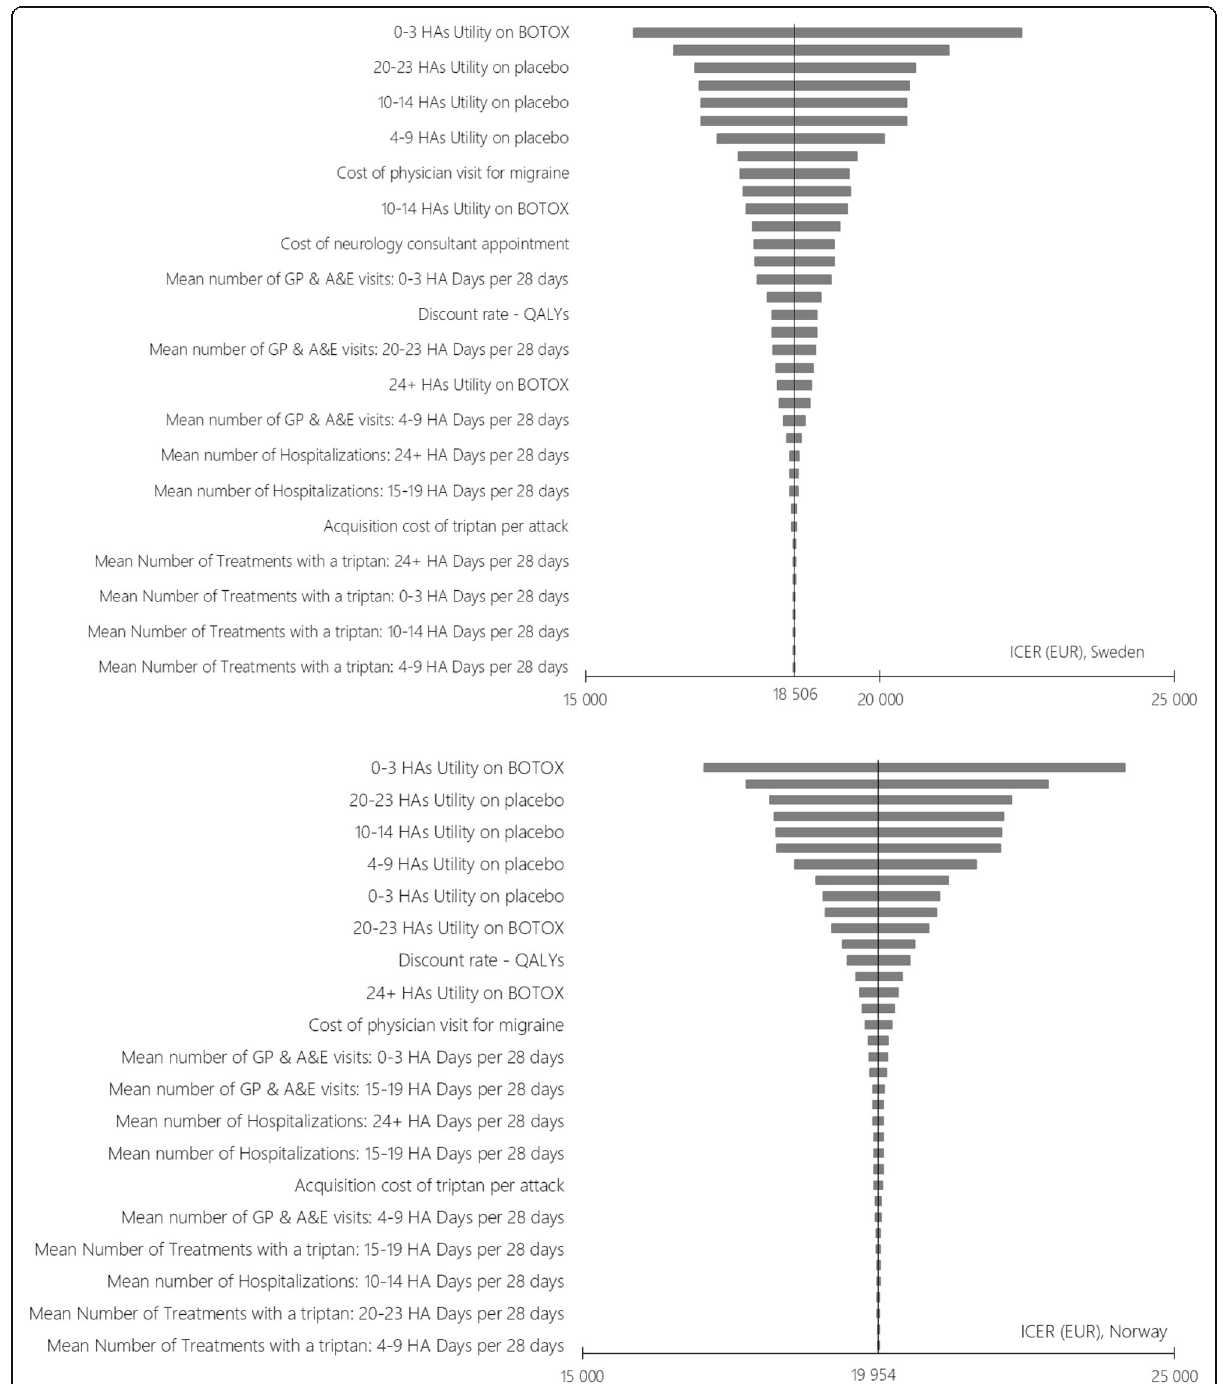
Fig. 5 Tornado Diagrams. Key: HA, headache; ICER, incremental cost-effectiveness ratio, QALY, quality adjusted life